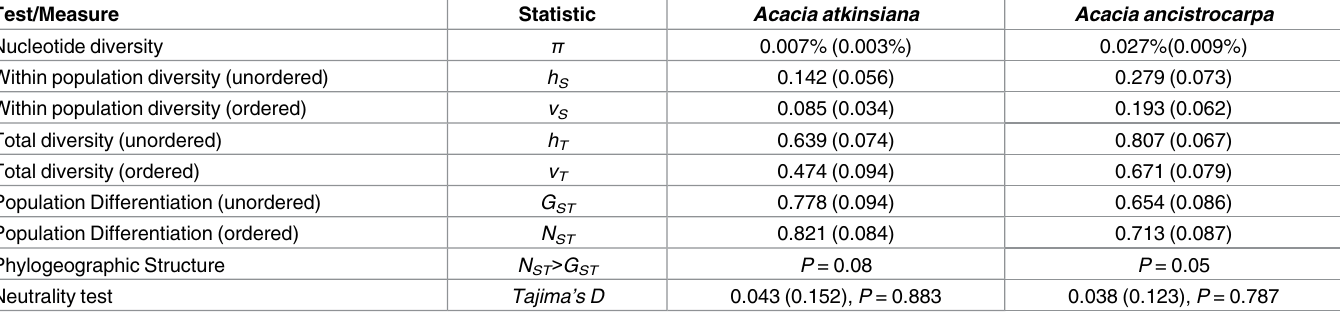
Table 2. Diversity, differentiation and neutrality indices for chloroplast DNA data of Acacia atkinsiana and A . ancistrocarpa . Standard errors are given in